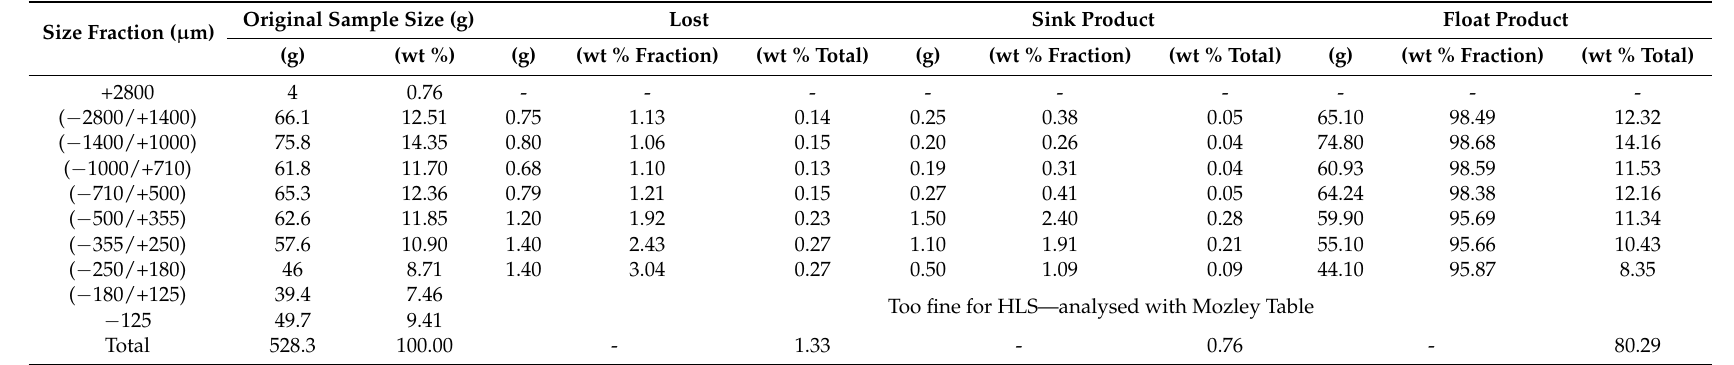
Table 3. Products produced from heavy liquid separation using SPT with a specific gravity (SG) = 2.86. Sink and float products are reported as weight per cent of that size fraction and weight per cent of the whole